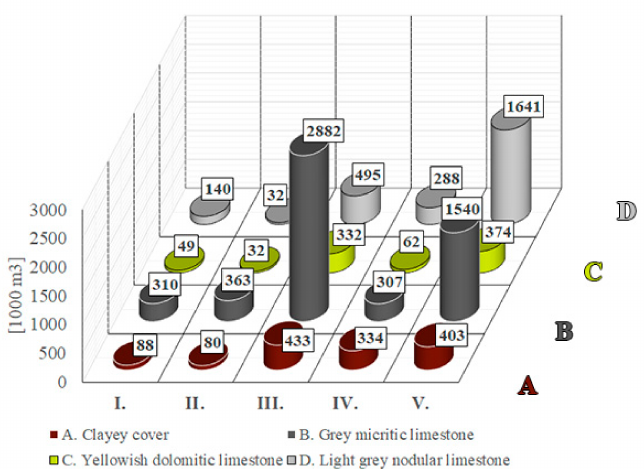
Figure 18. Calculated reserves in 1000 cubic metres of main lithological units (A–D) in blocks I–V (locations of the blocks are given in Figures 12 and 17and for lithological units and fault boundaries see Figure 16). Clayey cover beds (unit A) are waste material, while unit B has the highest quality limestone (see text for further